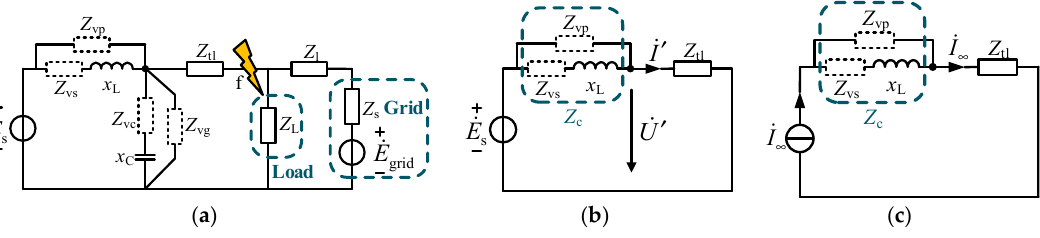
Figure 3. Transient equivalent circuits of a VSC-based renewable energy: ( a ) the whole circuit of three-phase short-circuit fault; ( b ) the circuit of fault transient period; ( c ) the circuit of fault steady